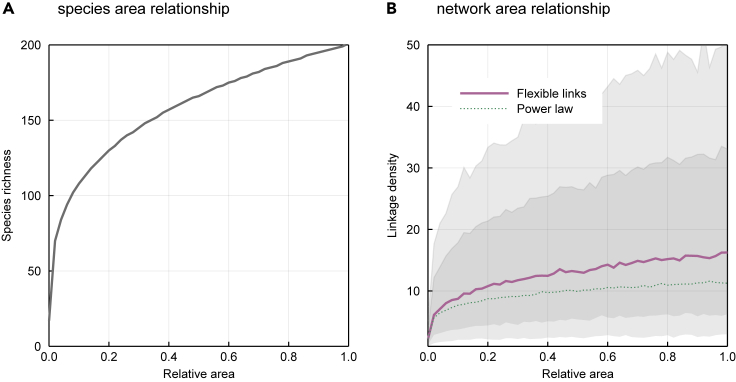
Many Different Network-Area Relationships Are Supported by the DataRepresenting the species richness as S = kAz (A), with A being the relative area size, k = 200 being the maximal species richness, and z = 0.27, a scaling exponent.26 We then use the posterior distribution of L to predict how LD should scale with A. We compare the predictions of our model with that of the generally accepted power law (Equation 3). While our model predicts a larger linkage density in larger areas (B), the confidence intervals around this prediction (gray areas covering the 78% and 97% percentile intervals) are extremely large. In particular, our model scales faster than the power law, but the confidence interval is high (due to the scaling of variance with S, Equation 10). This suggests that we may observe either very weak or very strong effects of area on networks.